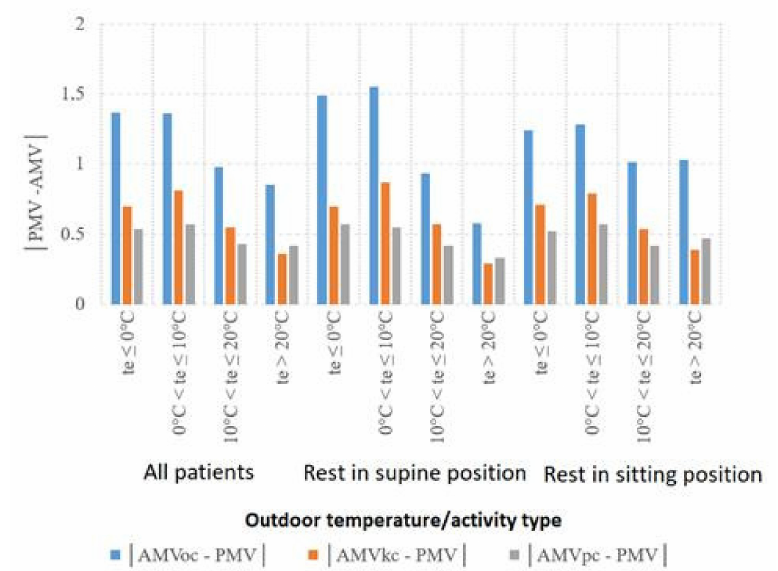
Figure 5. Difference between actual and predicted mean value of thermal conditions in different climate